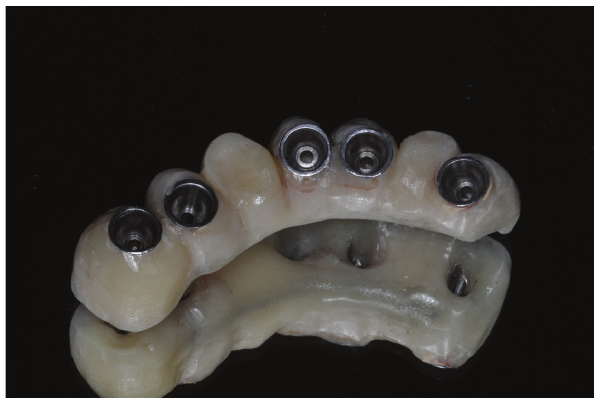
Figure 5: Provisional prosthesis.